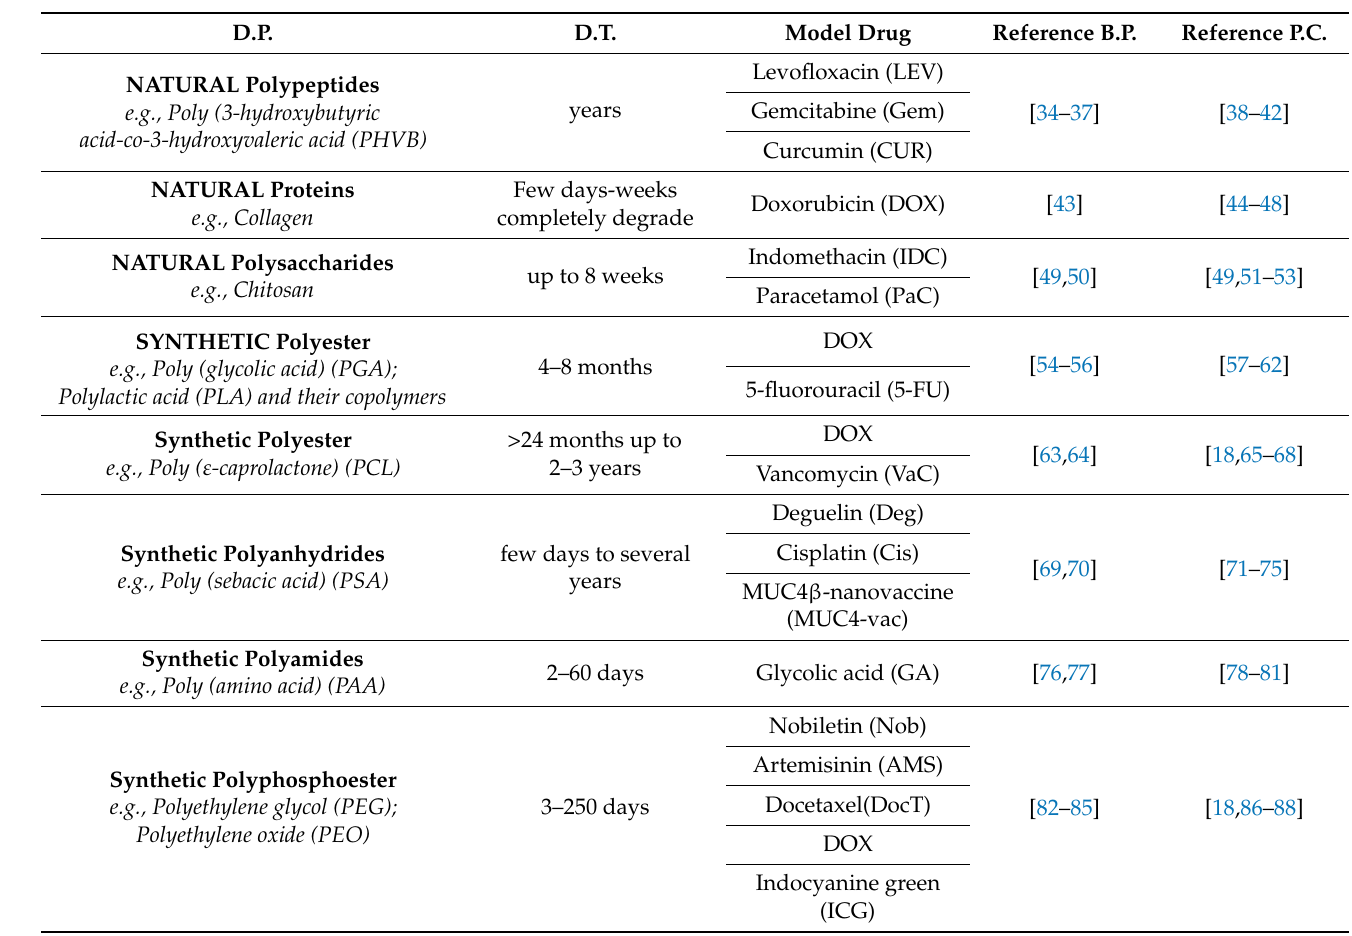
Table 1. Widely used degradable polymers for drug delivery applications in form of bulk (B.P.) and